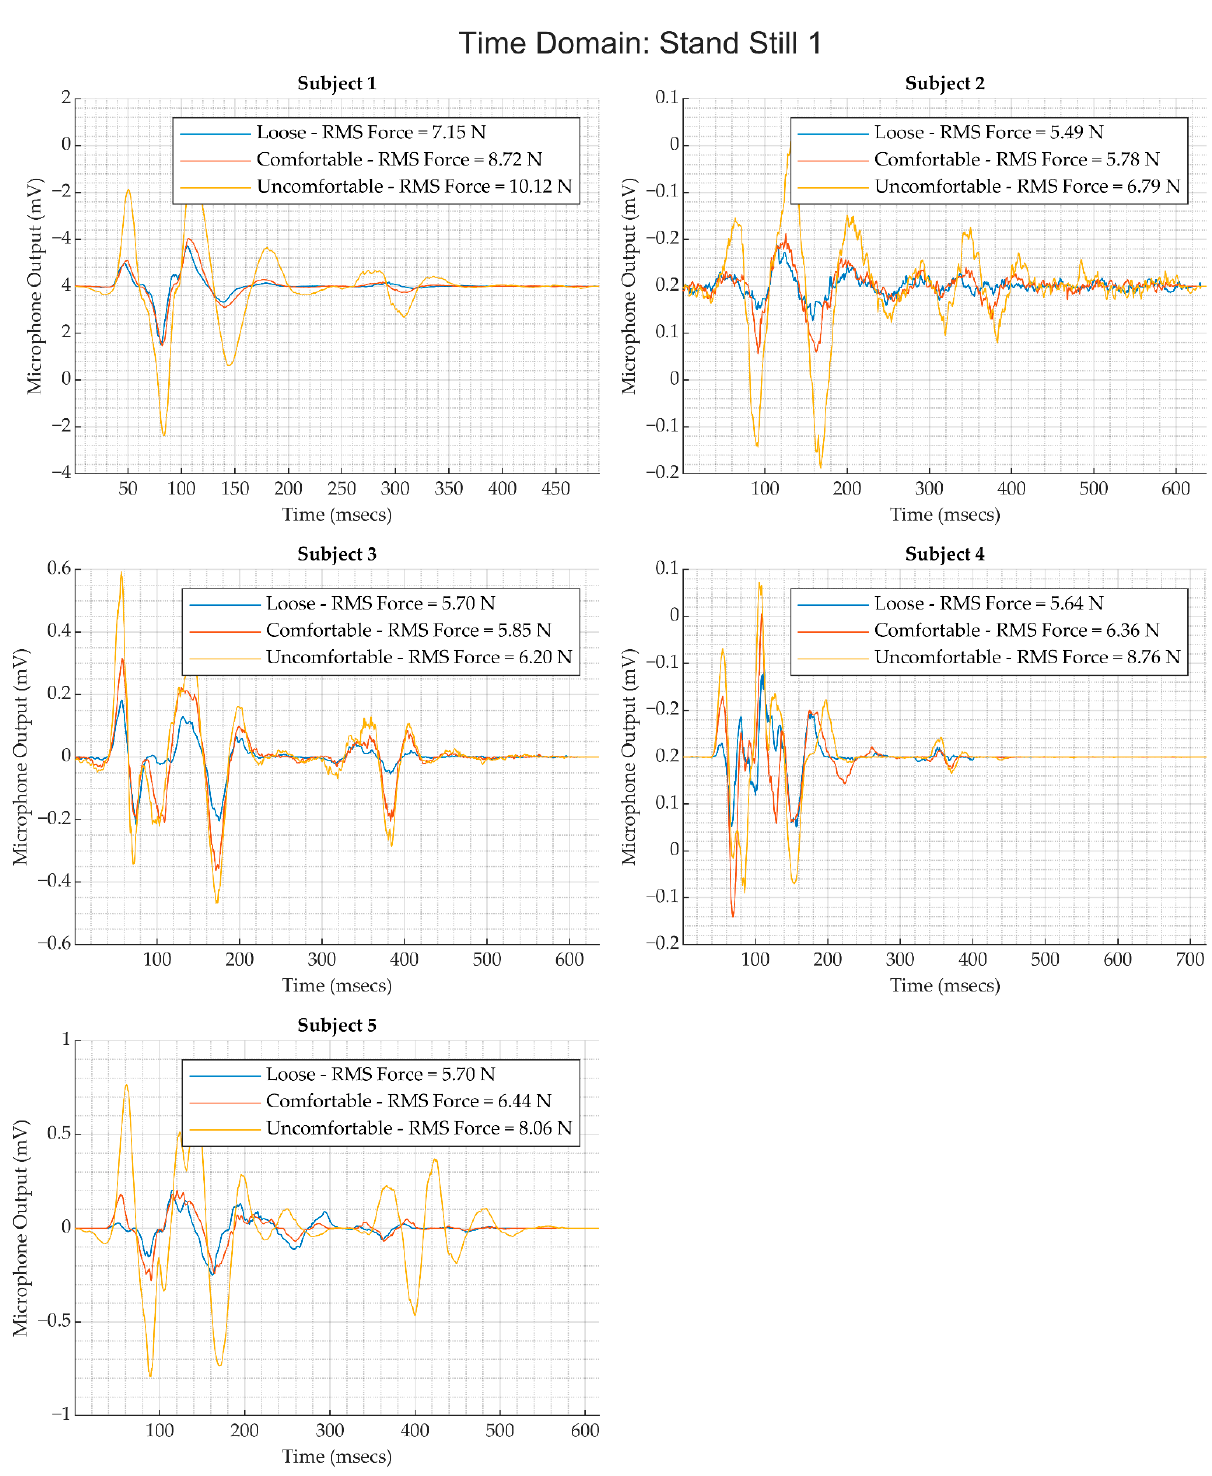
Figure 11. Overlapping plots in time domain of the ensemble medians representing heart sounds collected during activity Stand Still 1 at three levels of tightness for each subject.